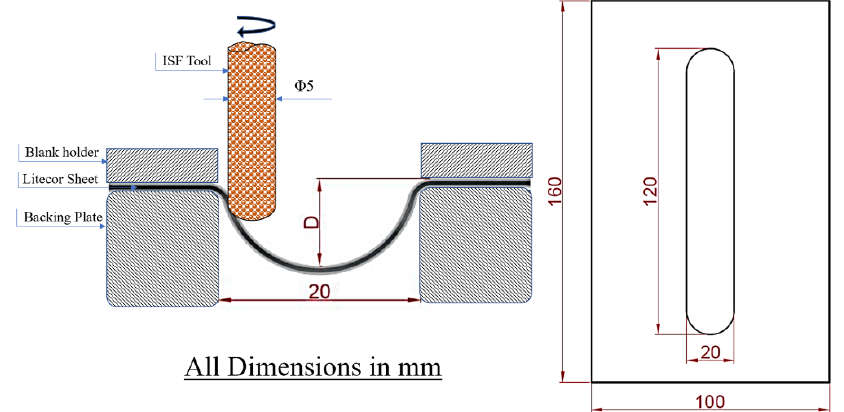
Figure 4. SPIF tool scheme and dimensions of the panel with stiffening rib in LITECOR ® .